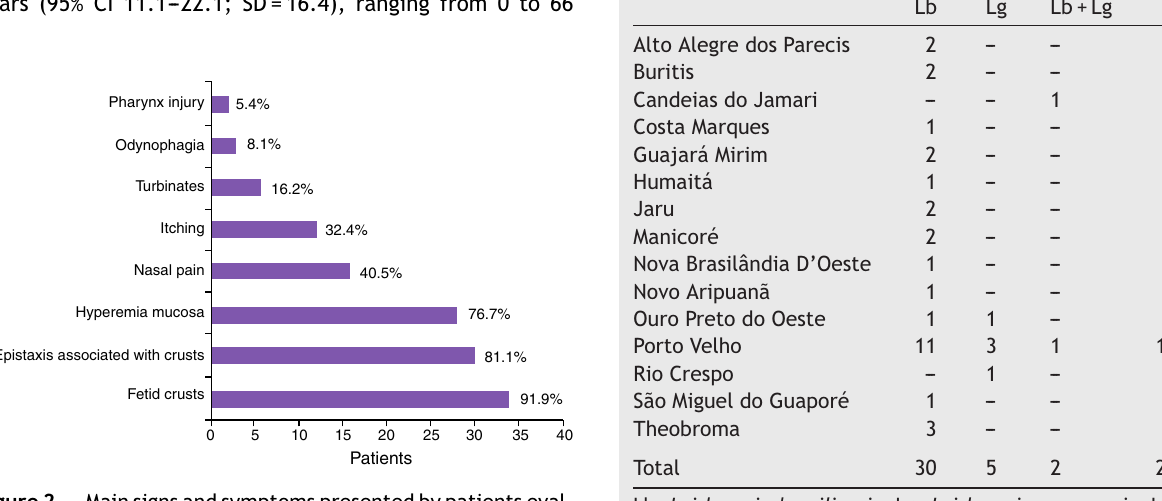
Leishmania species and presence of LRV1 virus.